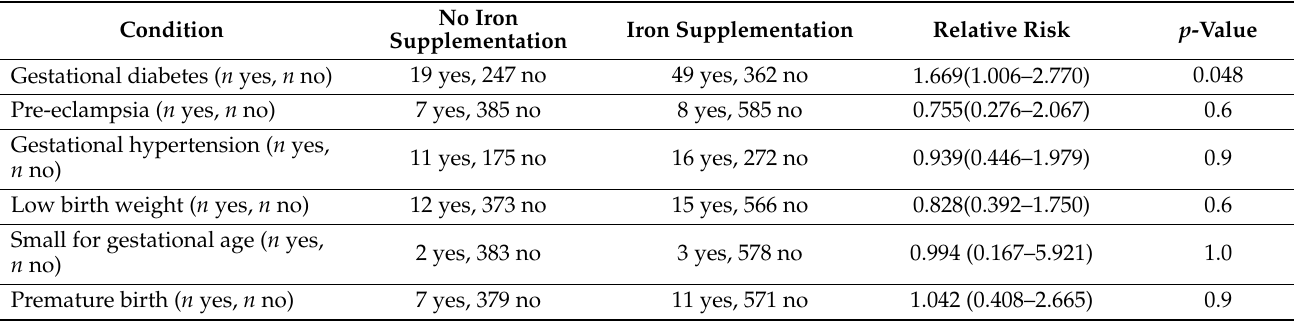
Table 2. Numbers and relative risks of various adverse conditions of pregnancy according to whether or not the participants supplemented their diets with